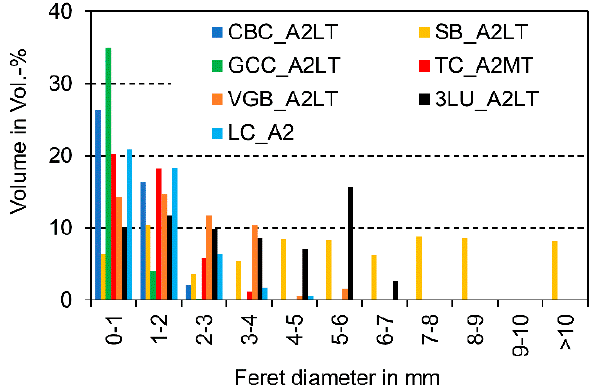
Figure 2. Filler size distribution (selection; see Supplementary Materials for overall results) based on one SEM picture with max. 5100 single particles.